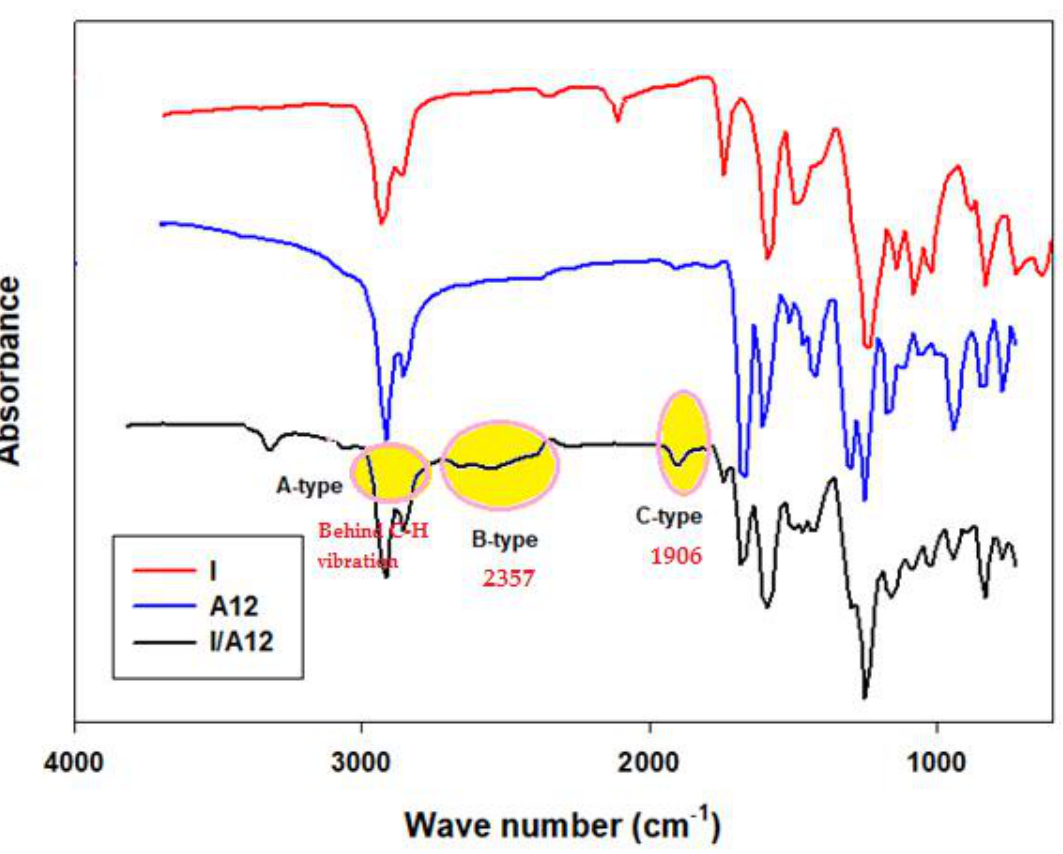
Figure 1. Fourier-transform infrared spectroscopy (FT-IR) spectra of I, A12 and their SMHB complex I/A12.